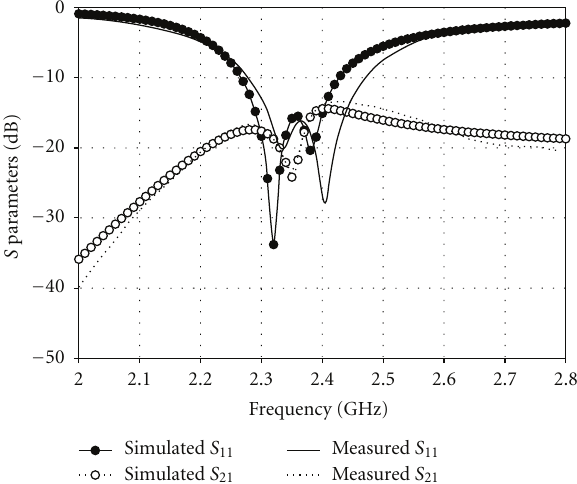
Figure 8: Simulated and measured S parameters